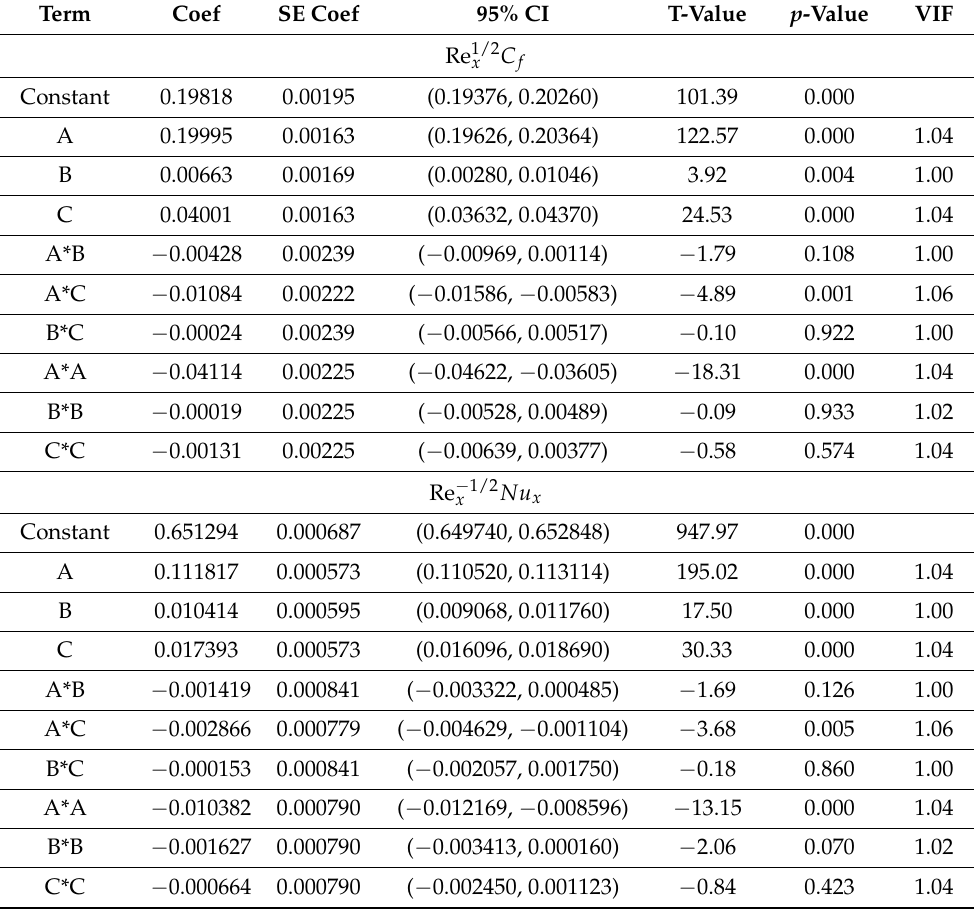
Table 9. Fitted model terms for the responses.